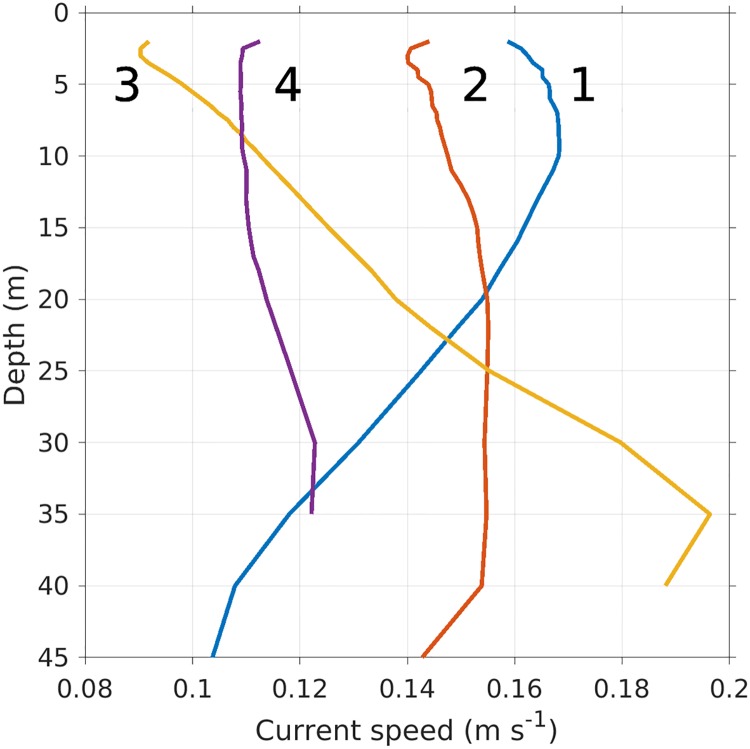
Depth profiles of simulated current speeds at the four “+”s numbered 1 to 4 in Fig 5.The profiles were averaged over a tidal cycle in August, 2015, when the current direction was roughly in the direction from +1 to +4. The large numerals at the top correspond to those in Fig 5.